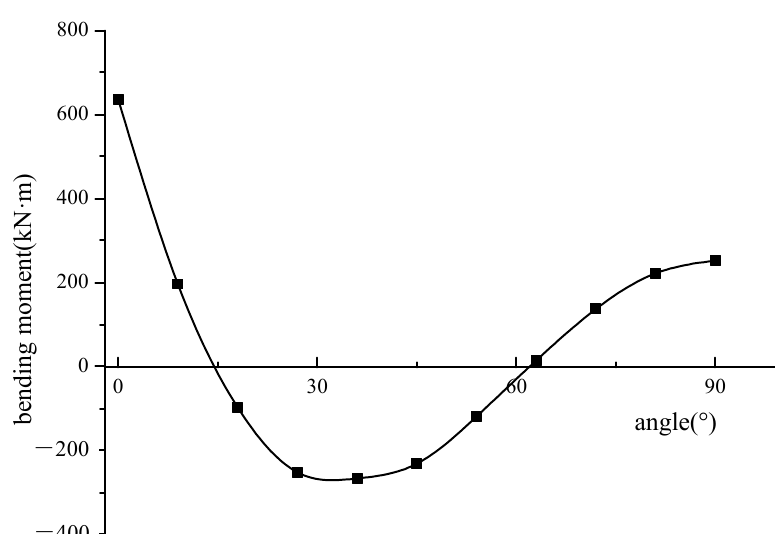
Figure 7. Structural bending moment under conventional load.